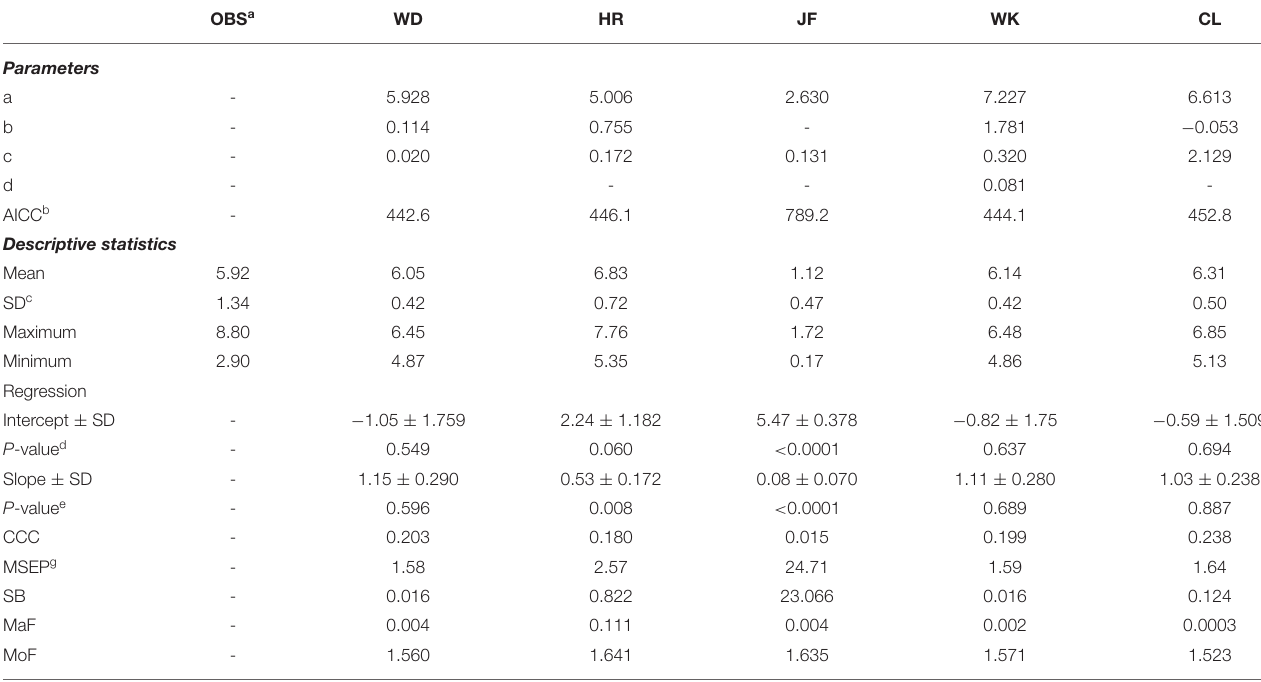
TABLE 5 | Equation parameters and descriptive statistics of the relationship between the observed and predicted values of milk production of nulliparous and primiparous Nellore cows under